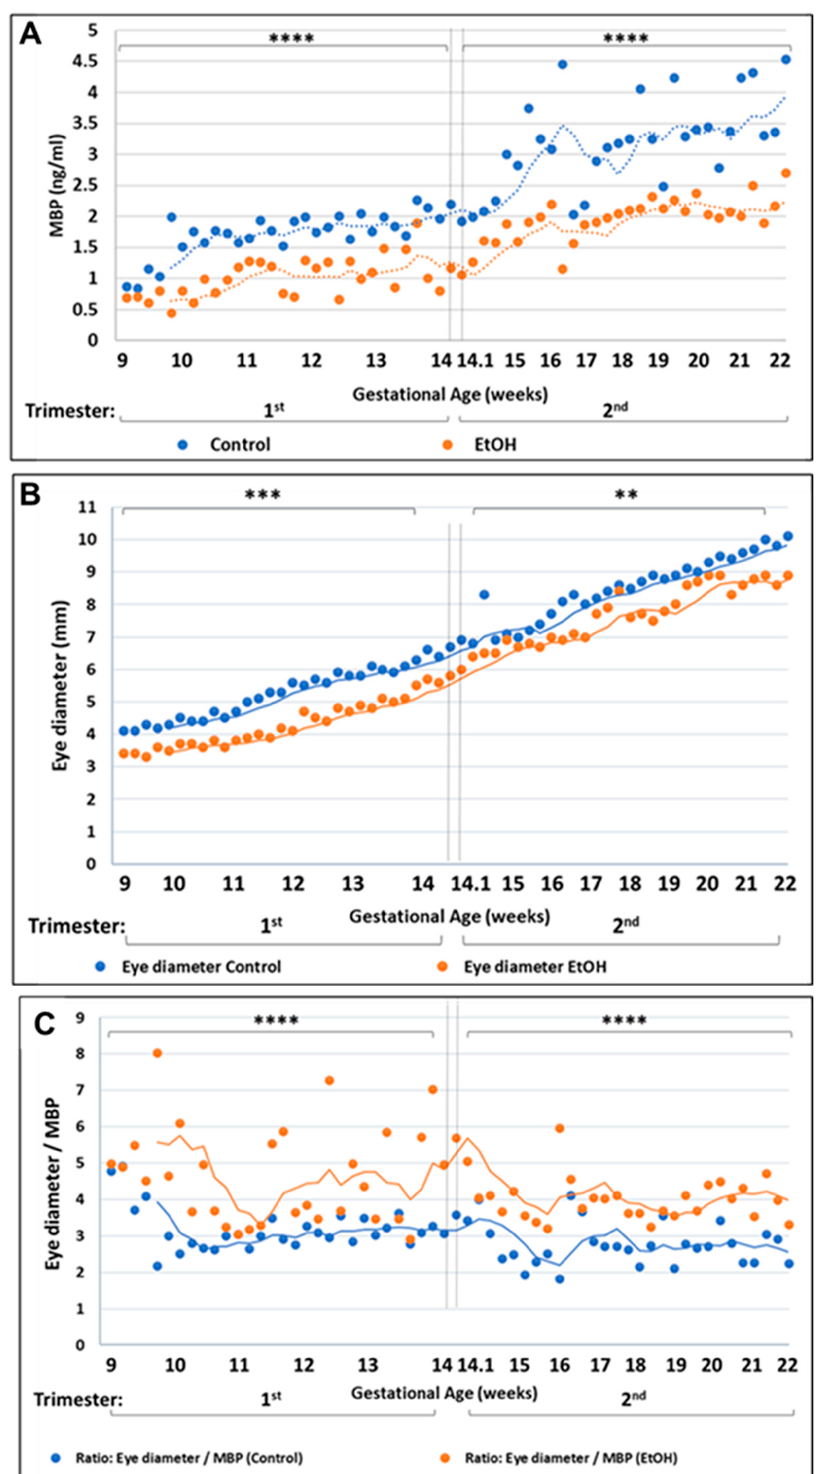
Figure 7. MBP levels in fetal brain-derived exosomes, and eye diameter changes during development in EtOH-exposed samples and unexposed controls. FB-Es were isolated from the blood of 60 mothers who drank alcohol during pregnancy and 60 GA-matched unexposed